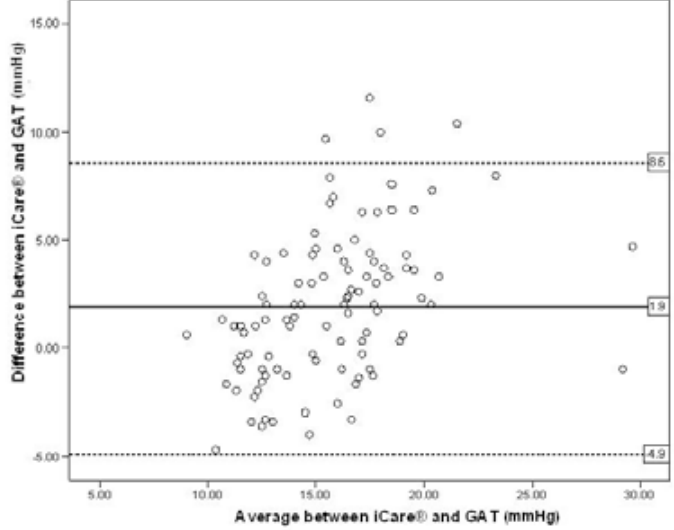
Figure 2: The Bland-Altman plot showing the difference be- tween the means against the average of the means for iCare ® and GAT measurements. Again, the solid line shows the mean difference (bias) and the small dashed lines represent 95% limits of agreement.